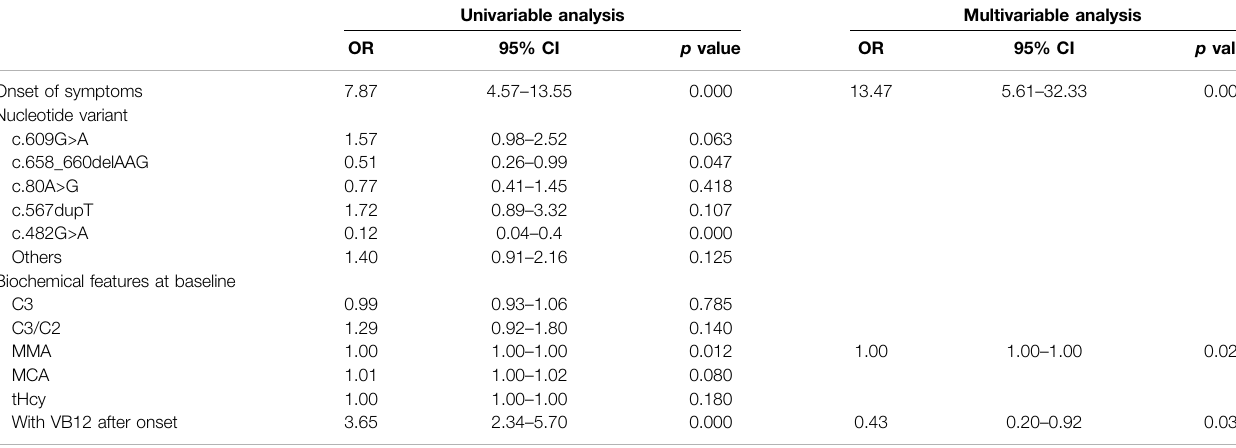
TABLE 6 | Univariate and multivariate analysis of predictors for movement disorders.